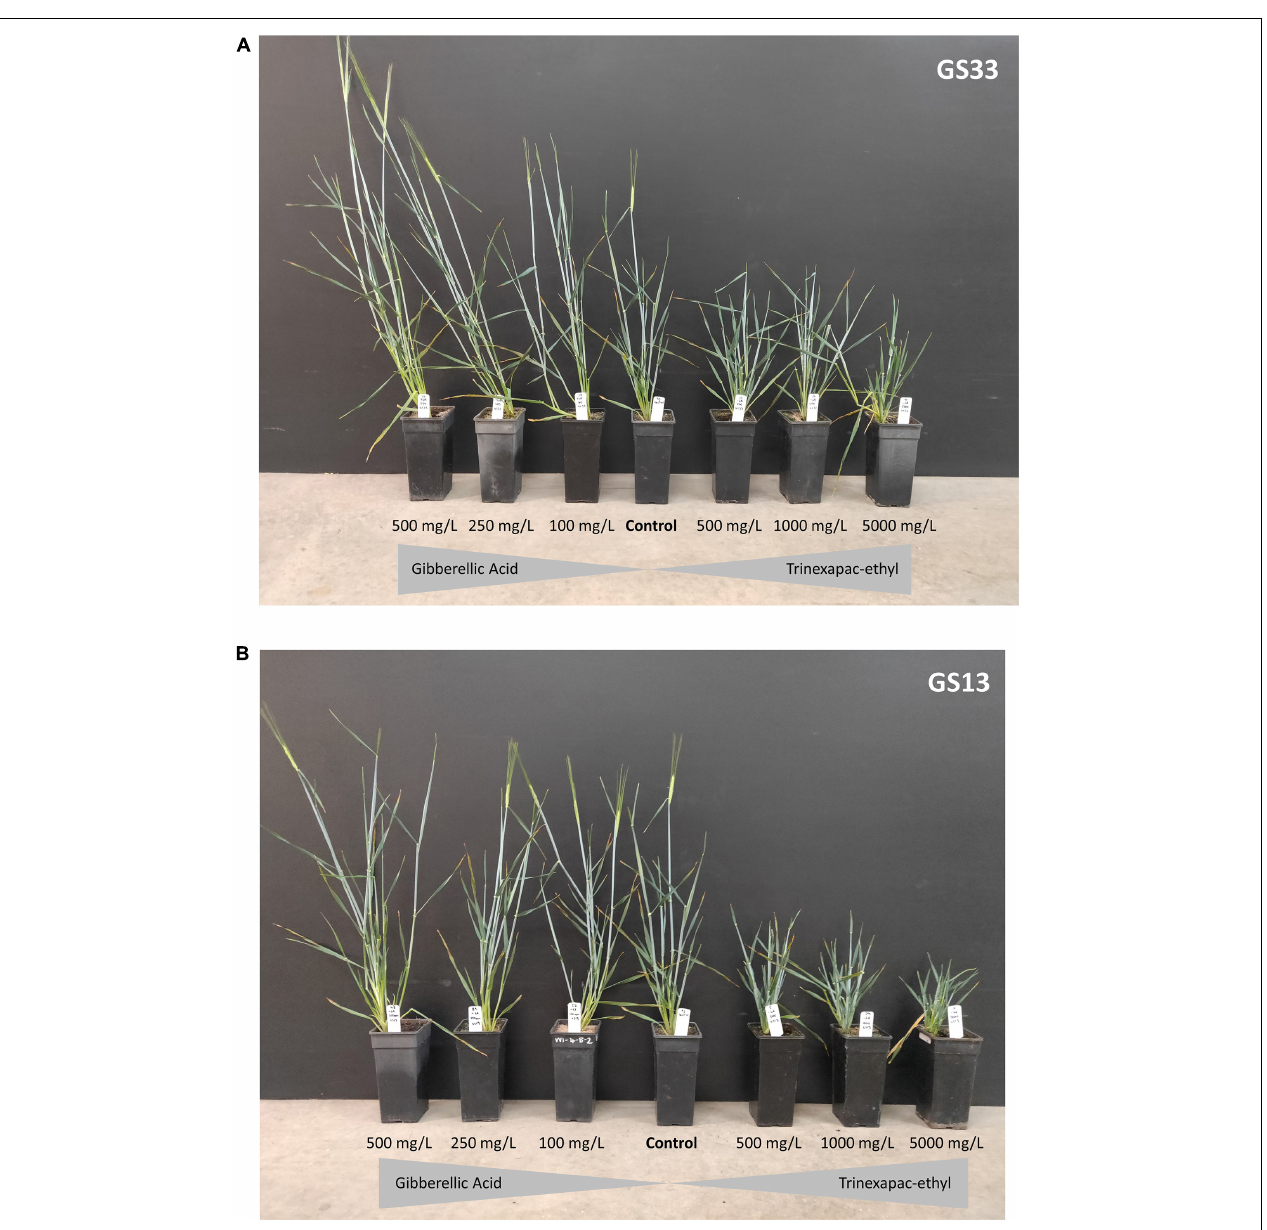
FIGURE 2 | A visual representation showing the effect of concentration and timing on the height and development speed of Spartacus CL with a spray application of gibberellic acid and trinexapac-ethyl at (A) GS33 and (B) GS13. One representative sample from four replicates at the three concentrations of each product are